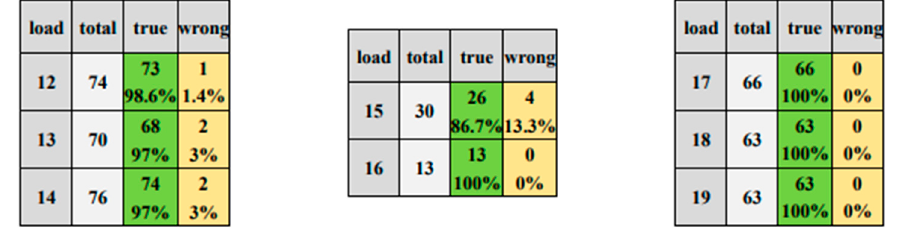
Table 4. Evaluation indexes of confusion matrix.